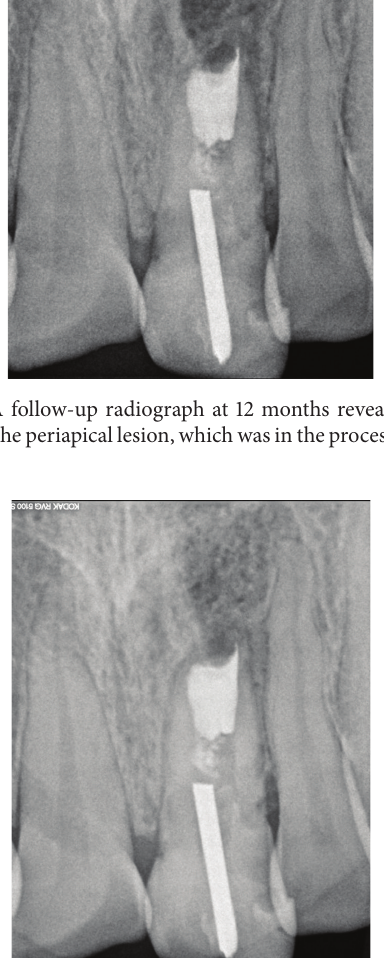
surgery first and leaving intentional replantation as a second- line